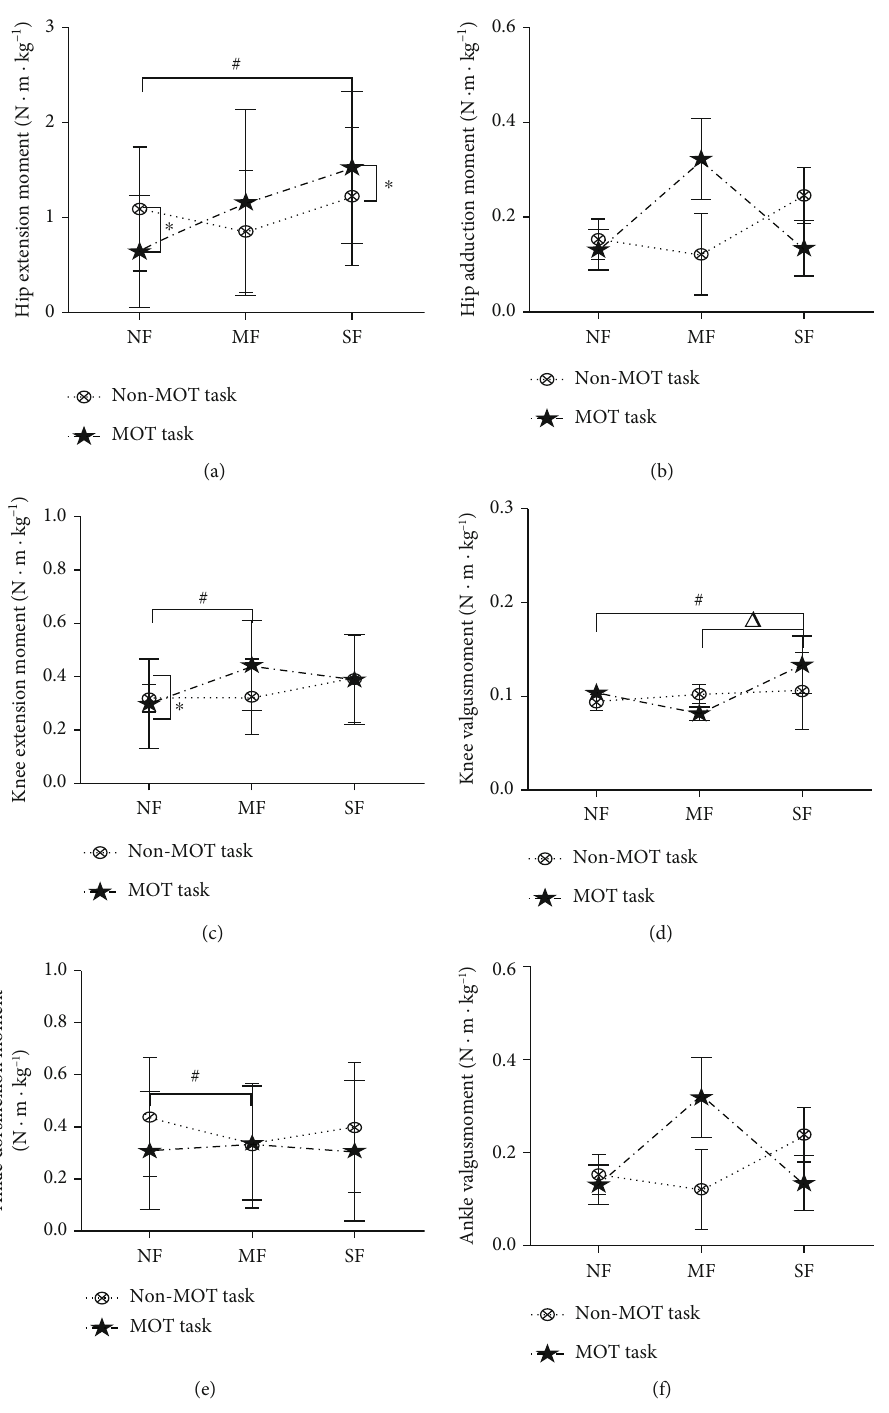
Figure 6: Changes of lower extremity joint